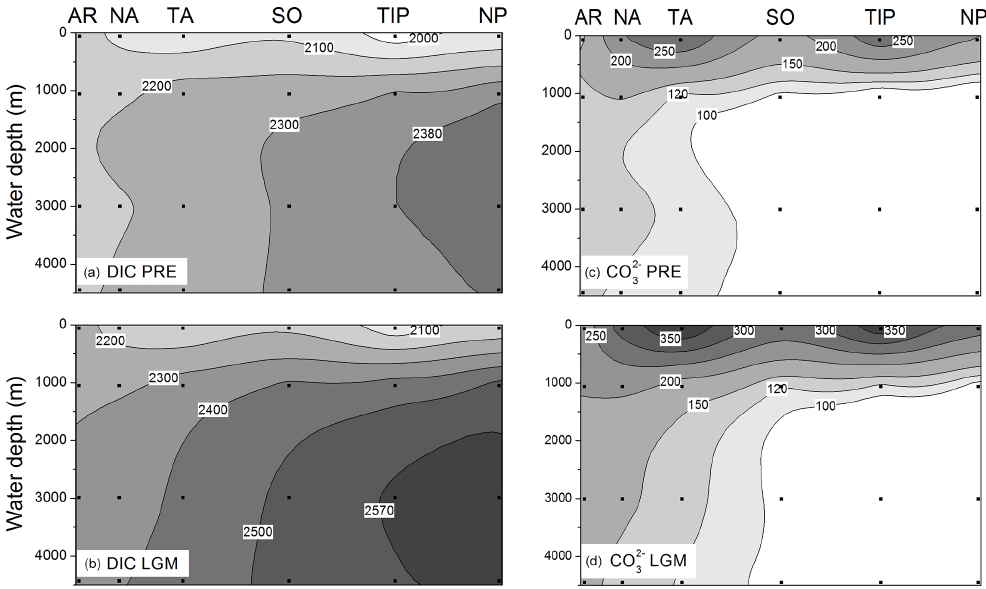
− in µmolkg − 1 ) in the pre-anthropogenic 3 , Table C4). 3